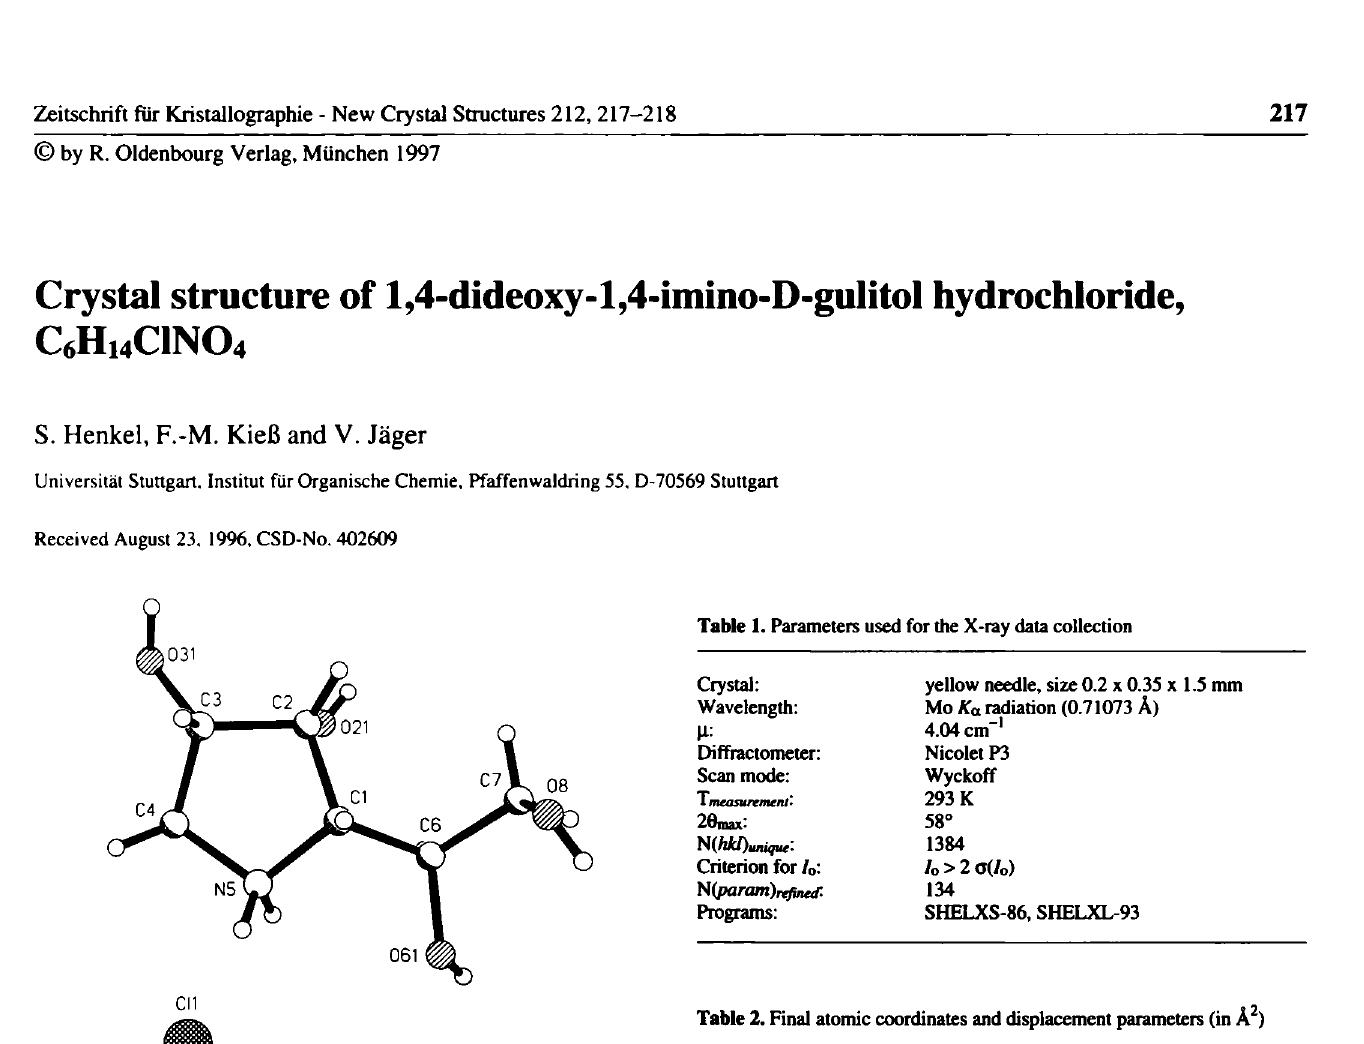
Table 2. Final atomic coordinates and displacement parameters (in Â 2 )